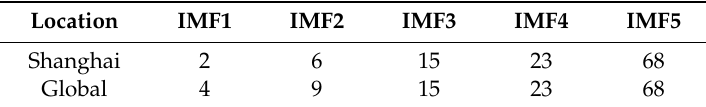
Table 1. The main period of each intrinsic mode function